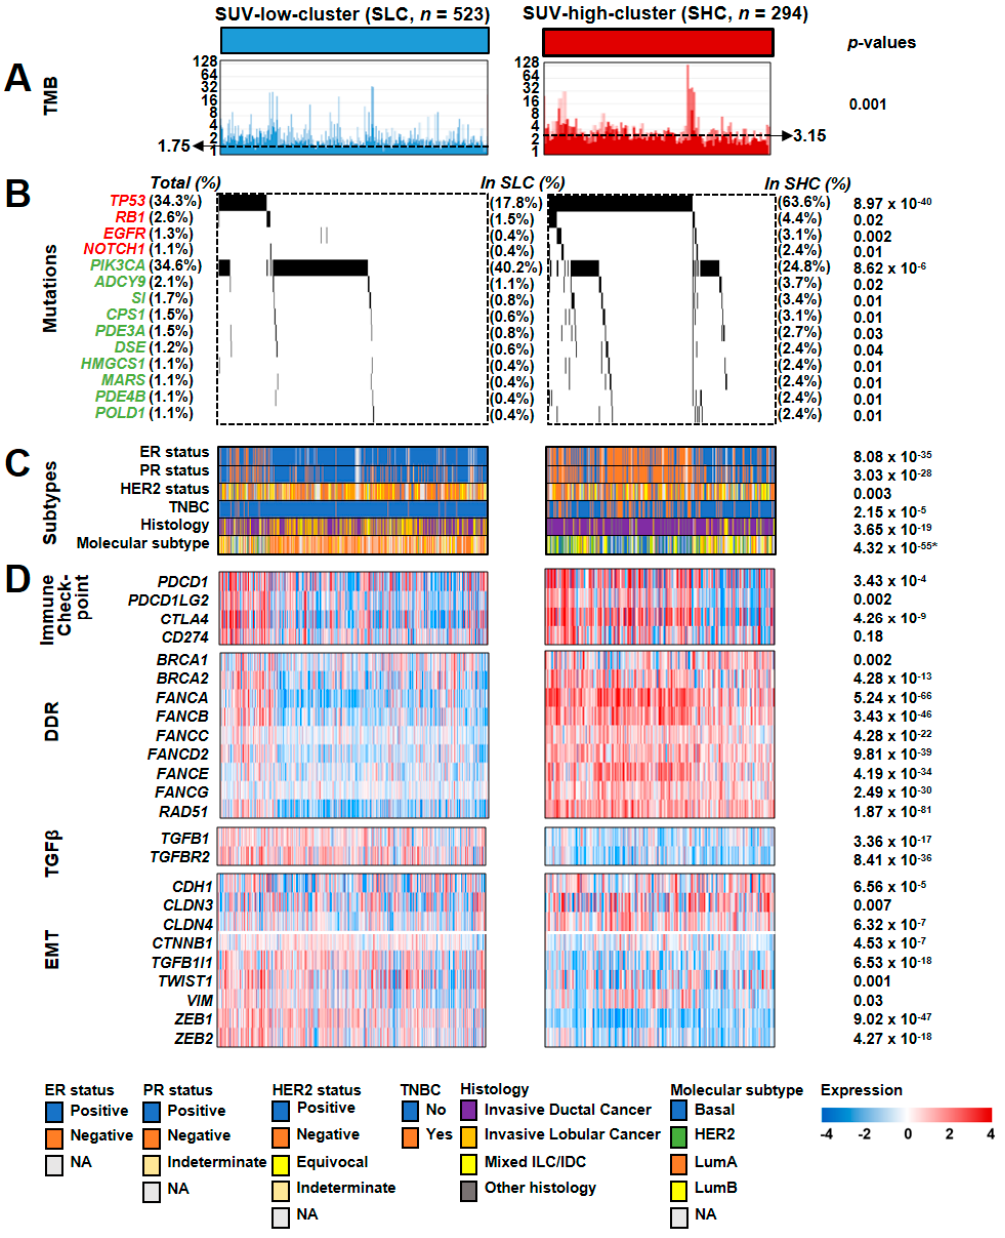
Figure 3. Association between standardized uptake value (SUV) subgroups and core molecular features in breast cancer (BRC). Molecular characteristics of the SUV subgroups were categorized by tumor mutation burden (TMB) ( A ), mutations ( B ), known subtypes ( C ), and heat maps of gene expression involvedincorepathways( D ).BRCsampleswereorderedbytheoverallmutationfrequencyofthegenes involved in the oncogenic signature or metabolic pathways. In the panel of mutations, gene symbols with a red color indicate involvement in the oncogenic signature, while gene symbols with a green color indicate involvement in the metabolic pathways. The p -values in the TMB and gene expression categories were obtained by two-sample t -tests. The p -value in the molecular subtype category was obtained by the χ 2 test, whereas the remaining p -values in the mutation or subtype categories were obtained by Fisher’s exact tests. DDR, DNA damage response; EMT, epithelial–mesenchymal